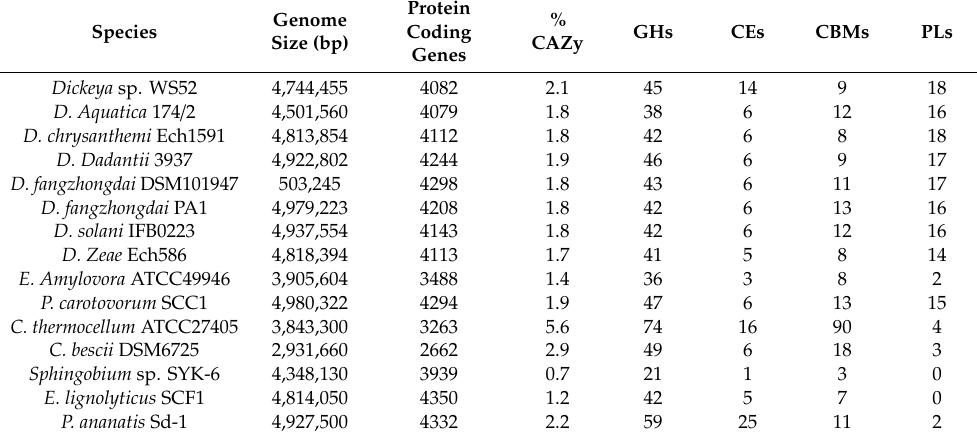
Abbreviations: % CAZy: Percentage of listed CAZy genes in protein coding genes; GHs: glycoside hydrolase family; CEs: carbohydrate esteraseses; CBMs: carbohydrate binding modules; PLs: polysaccharide lyases. To date, 71 Dickeya strains, 100 Erwinia strains, 148 Pectobacterium strains have been sequenced and deposited in the https: // www.ncbi.nlm.nih.gov / genome / . To date, 17 Dickeya strains, 13